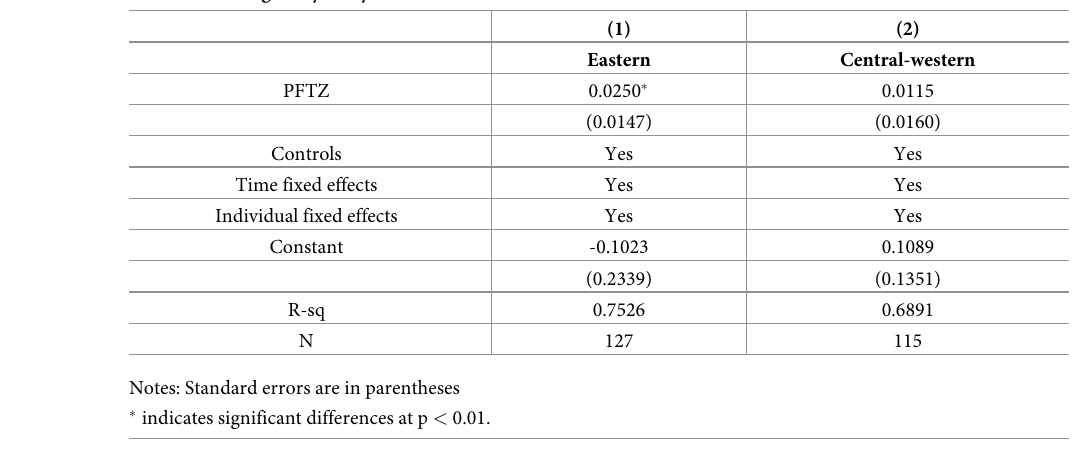
Table 8. Heterogeneity